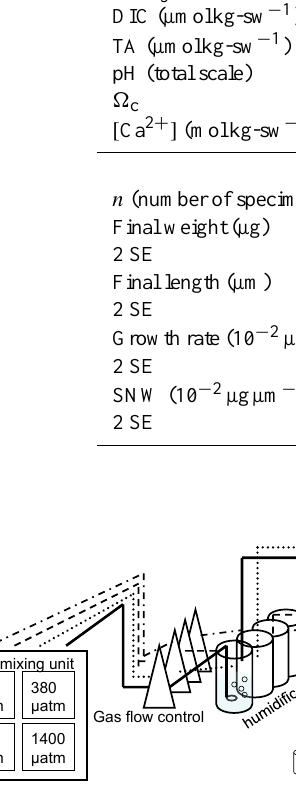
Fig. 1. Culturing setup: juvenile foraminifera were placed into petri dishes containing the manipulated seawater and placed into one of four gas-tight boxes, which were supplied with air of four different p CO 2 concentrations (Table 1) by a gas mixing system. Borosili- cate bottles containing the manipulated seawater were stored open in the boxes prior to water exchange in the culturing petri dishes to allow for pre-equilibration. Please note that p CO 2 values given in the figure represent those supplied by the gas mixing system (“nom- inal” values in Table 1). The actual p CO 2 value in the culturing